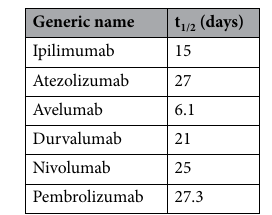
Table 1. Drug elimination half-life times t 1/2 in days of checkpoint inhibitors 40